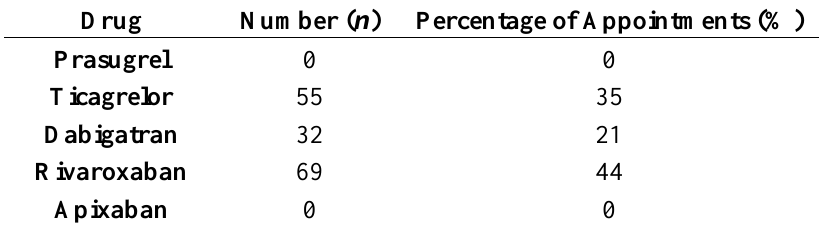
Table 1. Distribution of patients taking a Novel oral antiplatelet (NOAP) or direct oral anticoagulant drugs (DOAC) in Orkney who attended a dental